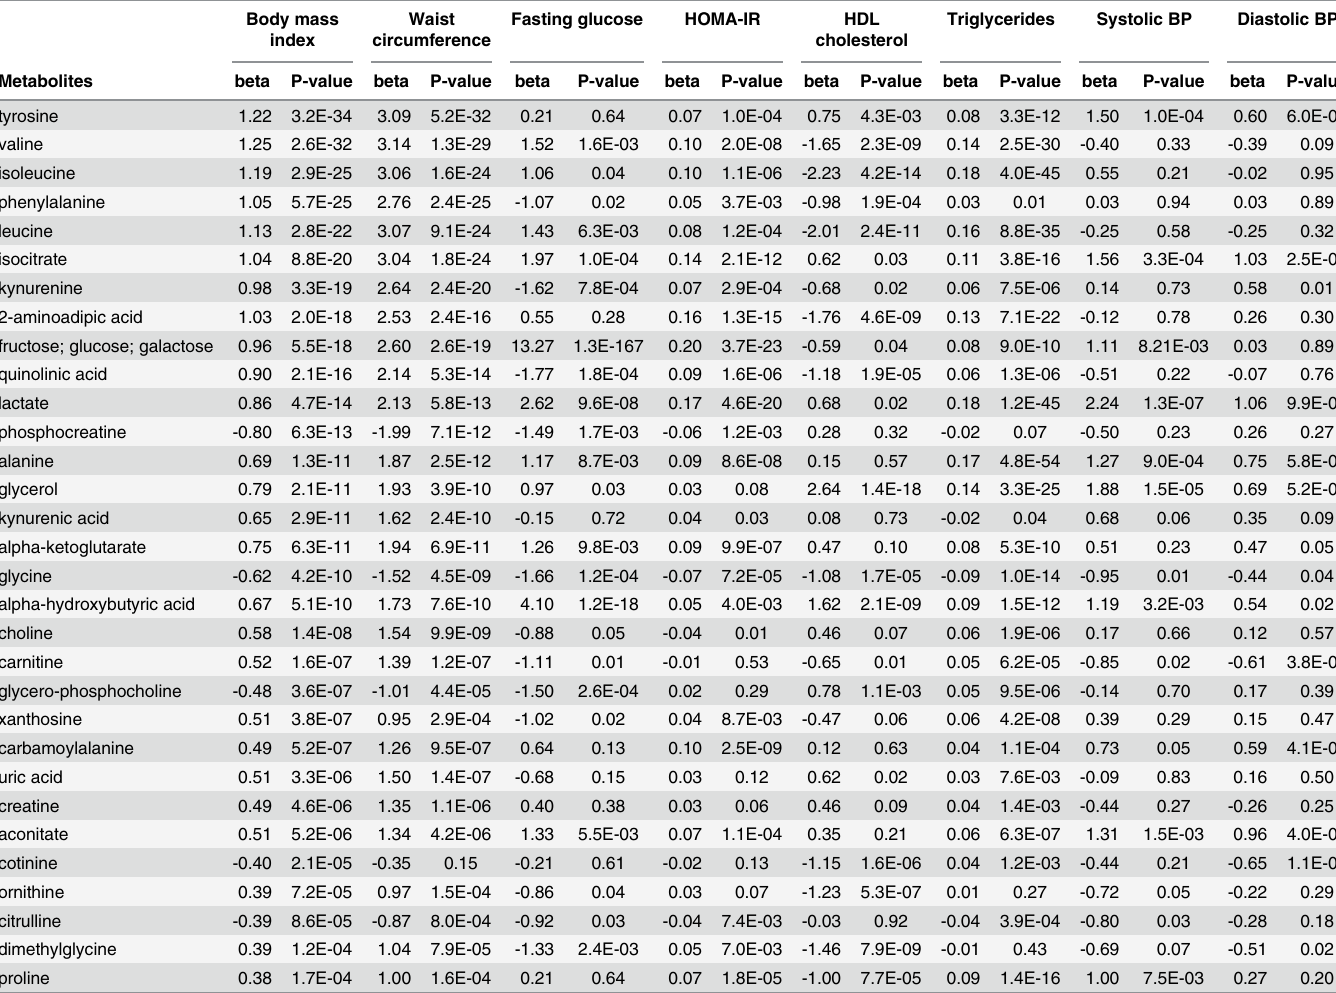
Table 2. Associations of non-lipid metabolite profiles with BMI and other metabolic